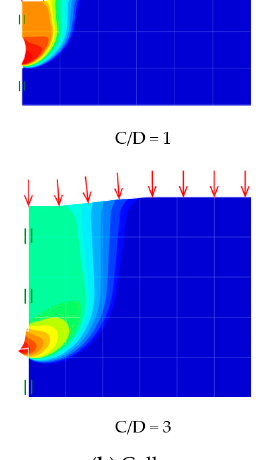
Figure 16. Design charts for γ D/S u = 3. Contour plots of the absolute velocity fields of the elliptical cavity shape transfor- mation are presented in Figures 17–19 for various width to height ratios ( B/D = 0.5, 1 and 2). These plots are both blowout and collapse modes with a shear strength ratio ( γ D/S u = 2) and two depth ratios ( C/D = 1 and 3). In general, the failure extent in the collapse mode is greater than that in the blowout mode. This observation is supported by noting the location of the initial slip surface points from the inner cavity (see Figure 19). A chimney- type of failure is presented for the shallow depth ratio C/D = 1 in both the blowout and collapse scenarios and larger lateral expansions are seen in the deeper case C/D = 3, which supports the fact that greater σ t is needed to cause soil blowout failure or to prevent soil collapse. Noting that the absolute values of the coloured velocity fields are not real for such a perfectly plasticity soil model, and therefore they are not presented here.